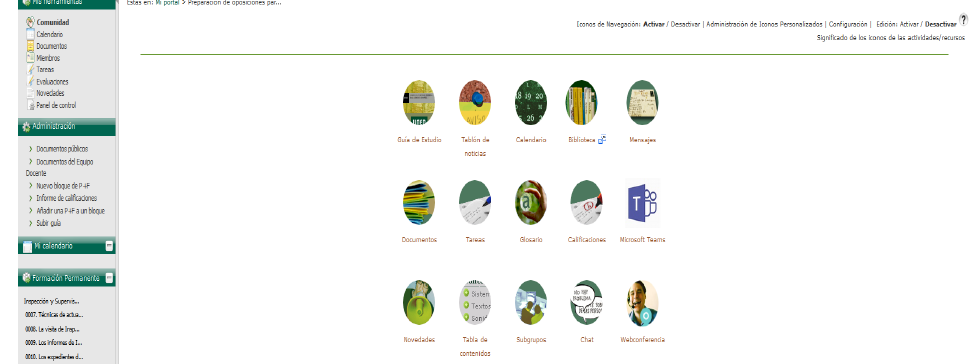
UNED’s aLF: LMS Digital